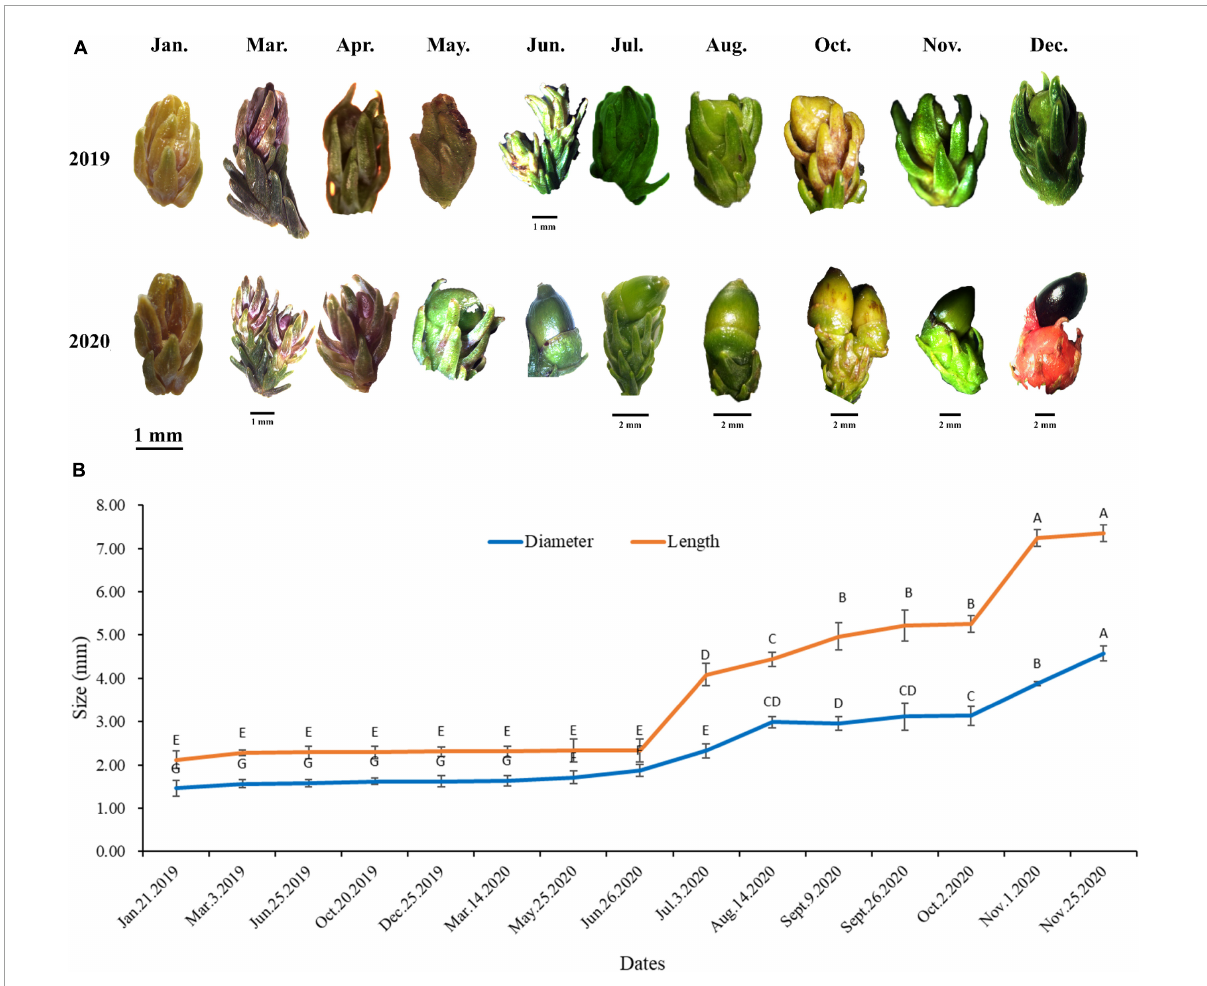
FIGURE1 External morphological images (A) and size (B) of female cones of Dacrydium pectinatum at different developmental stages. Specimens were collected from Changjiang County, Hainan Province, China. Different letters among length or diameter indicate significant difference at p < 0.05, and N =